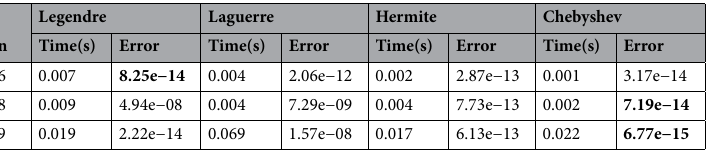
Table 3. Comparision of maximum relative error for Example 6.2 with different numbers of neurons. Significant values are in